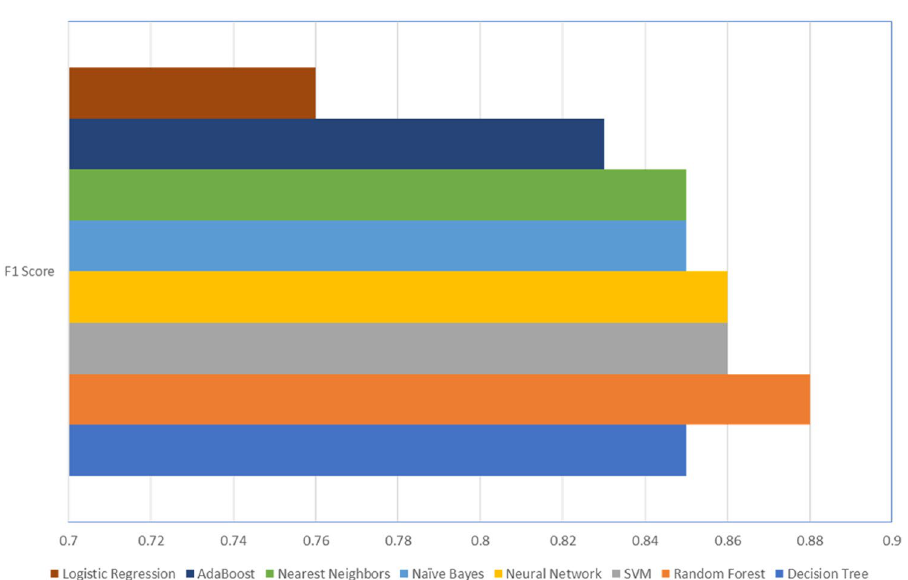
Figure 11. F1 Score provided by the eight algorithms considered in the